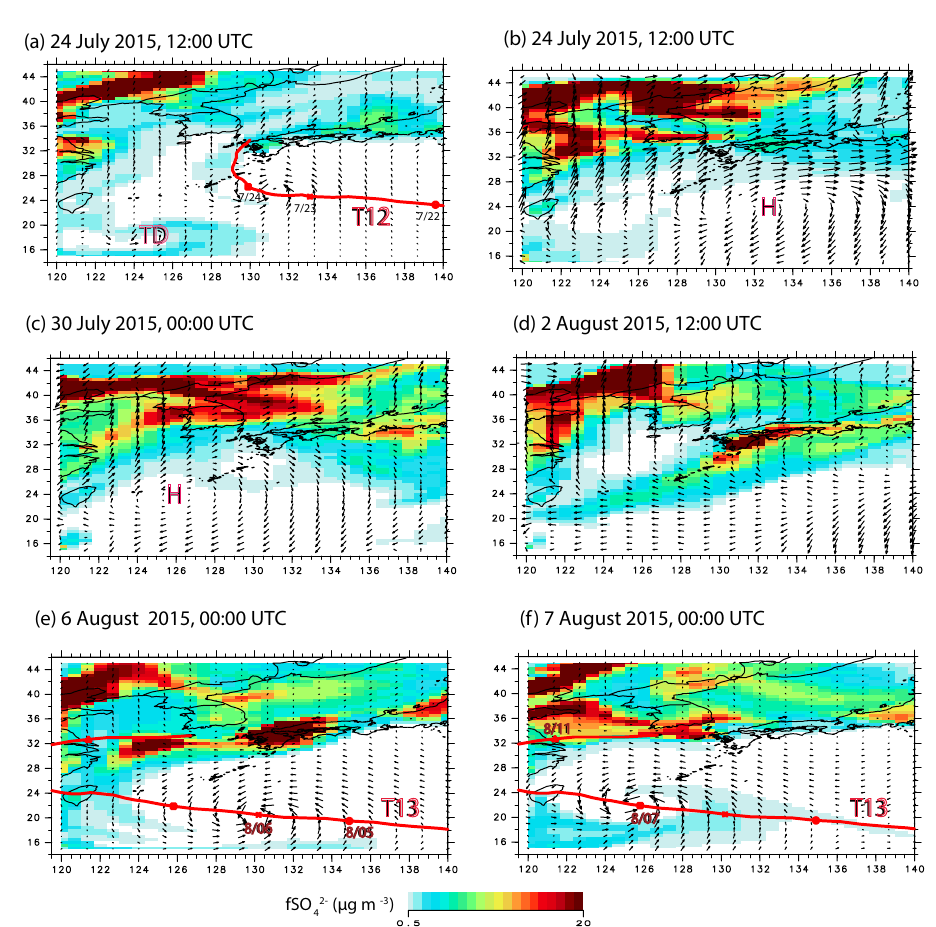
Figure A1. Horizontal distribution of fine SO 2 − (color) with wind vectors from model’s first vertical level (65m). The red line indicates the 4 trajectory of Typhoon Halola (T12) in panel (a) , and Typhoon Soudelor (T13) in panels (e) and (f) .